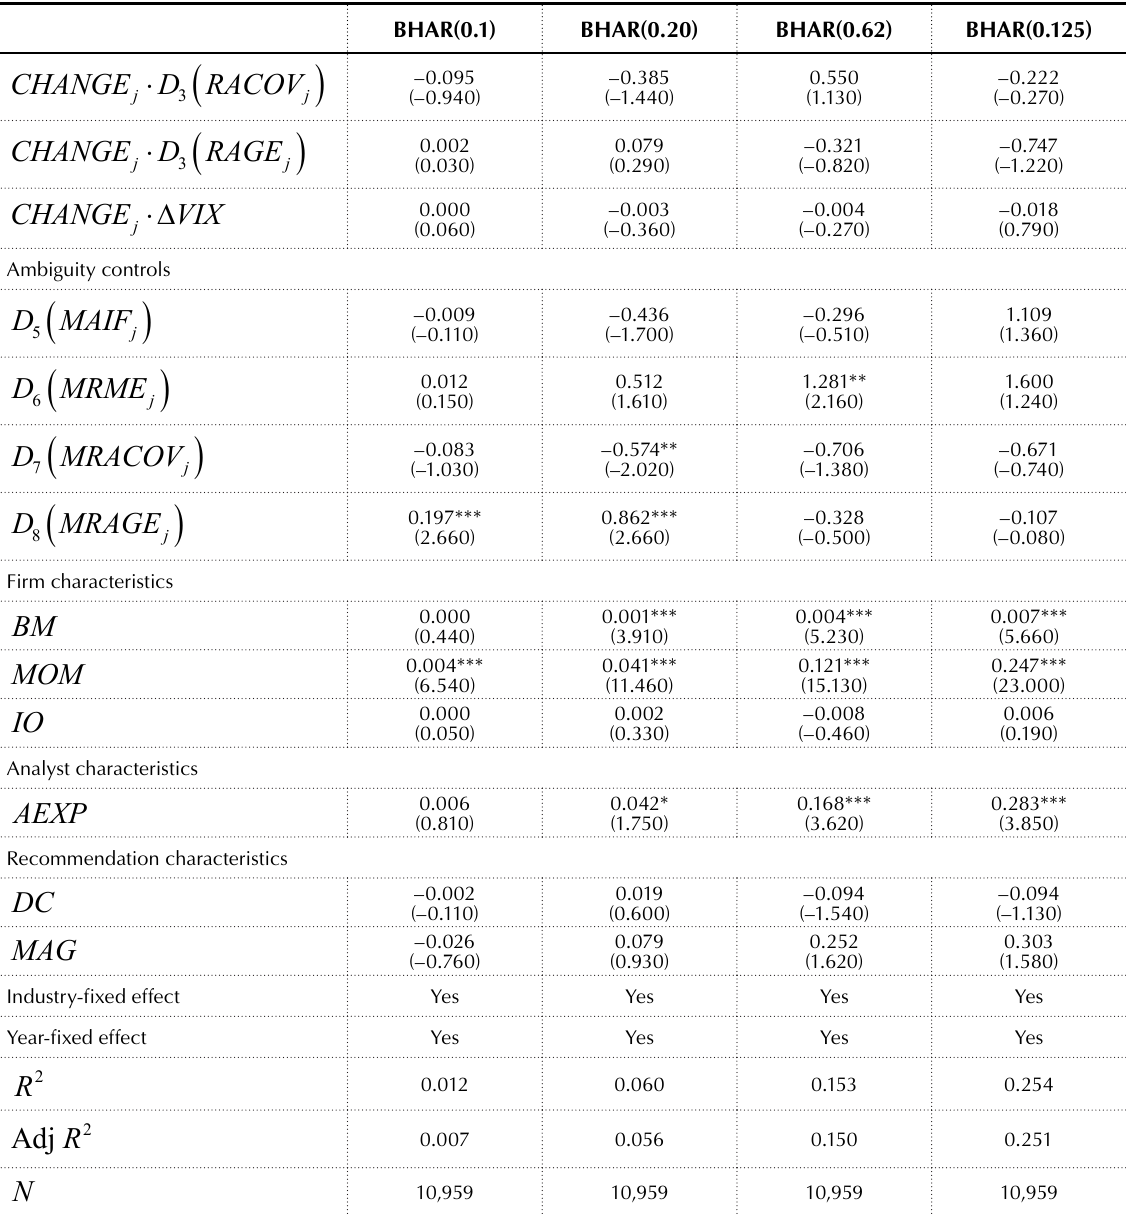
Table 5 (cont). Ambiguity and BHARs: controlling for both ambiguity and